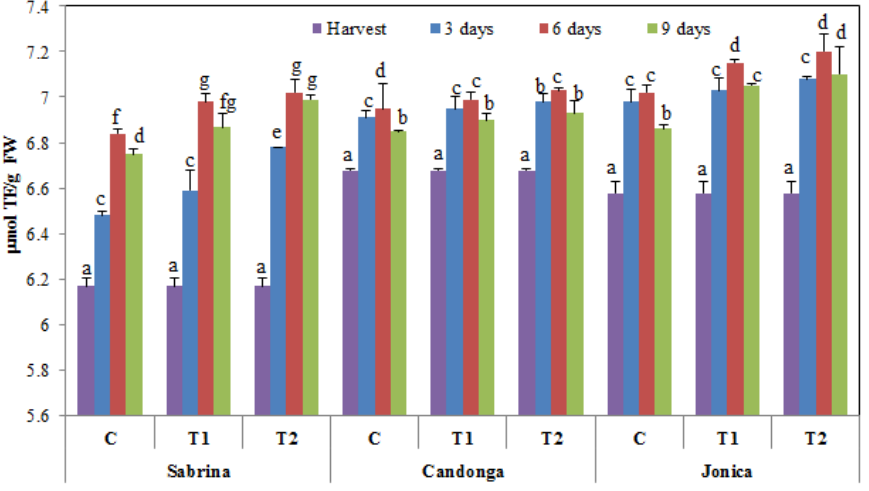
Figure 4. Changes in total antioxidant activity of strawberry cultivars during cold storage at 2 °C for nine days (error bars indicate standard